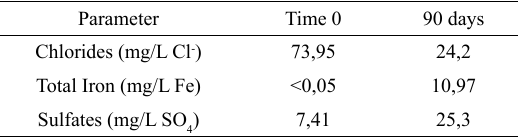
Table 1. Physical-chemical results of tap water. Parameter